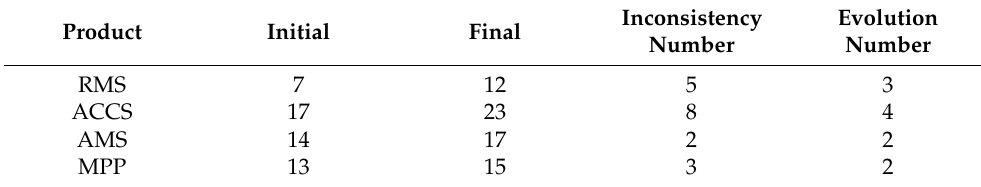
Table 6. Product family evolutionary